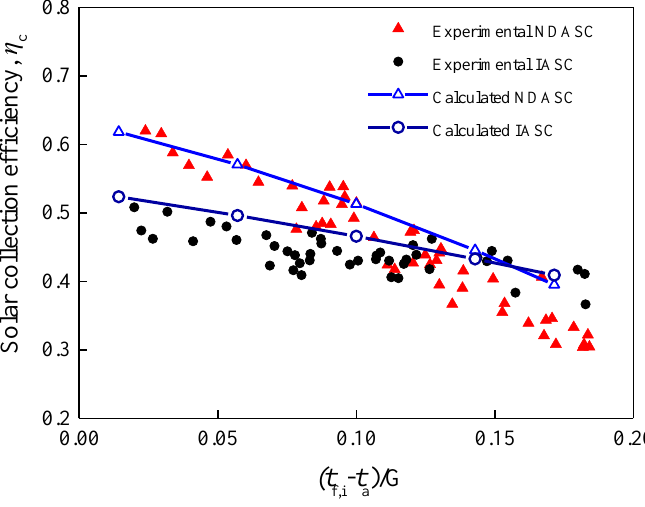
Figure 13. Comparison of the experimental and theoretical solar collection efficiencies for two